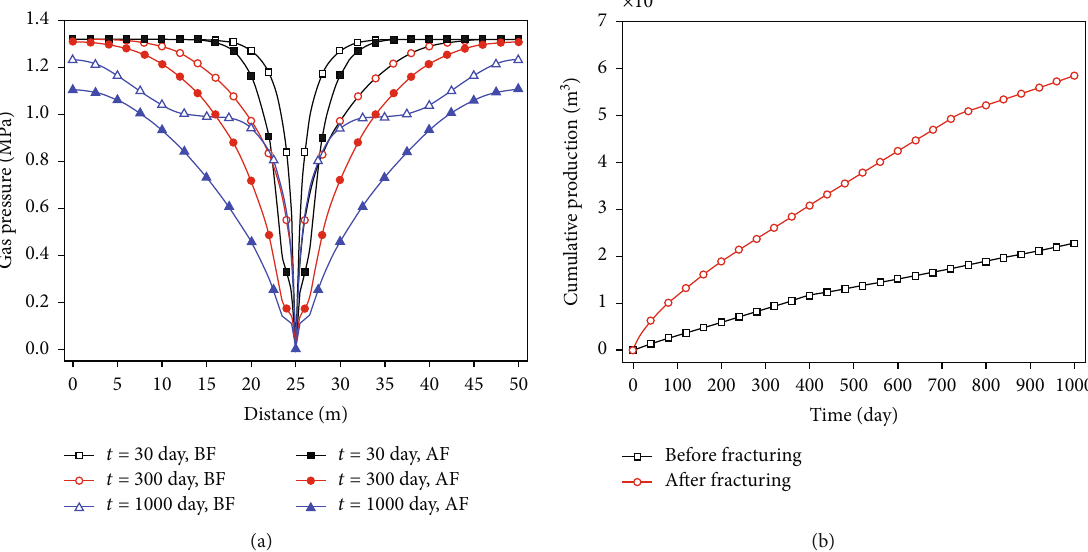
Figure 17: Gas pressure and cumulative production before and after fracturing: (a) gas pressure of line AB and (b) cumulative production of coalbed methane.